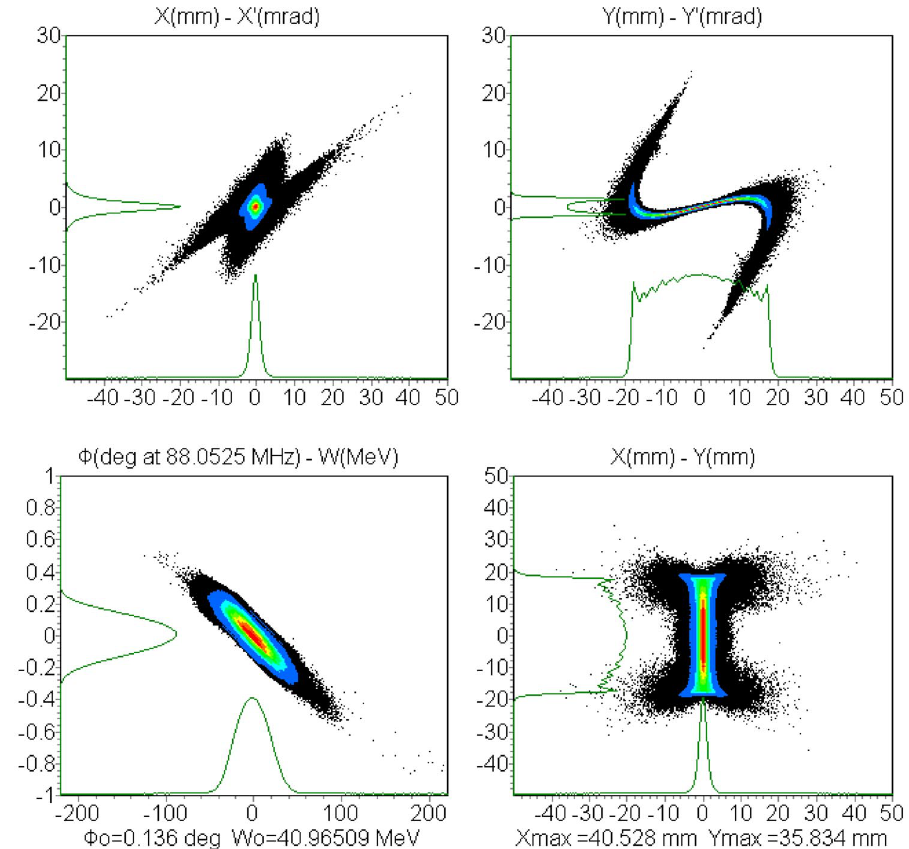
FIG. 18. (Color) The probability distribution contour map obtained by the normalized superposition of the 1000 output beam distributions.